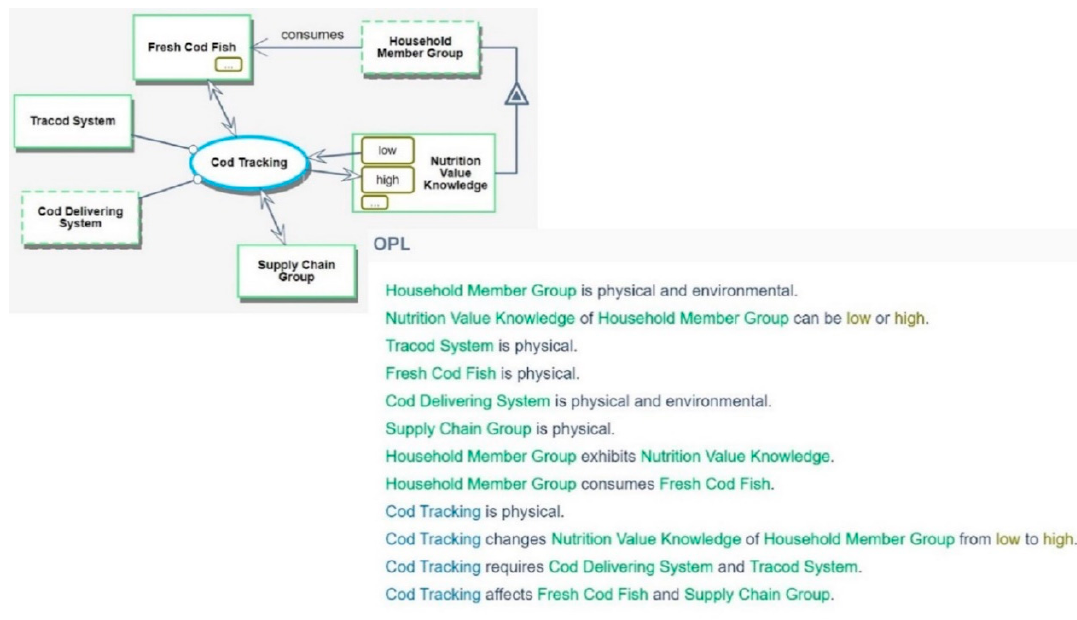
Figure 3. System diagram (SD) of codfish supply chain OPM model prepared by food and modeling experts.